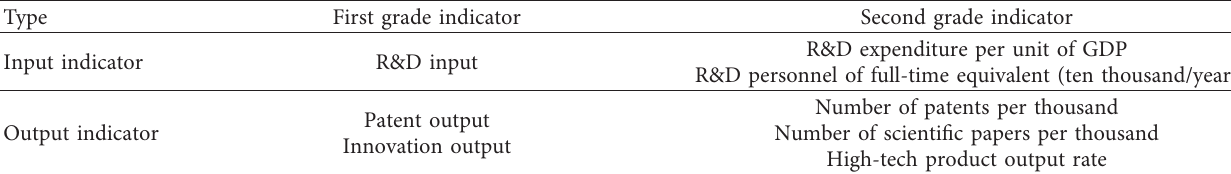
Table 1: The evaluation index of input and output performance of R&D